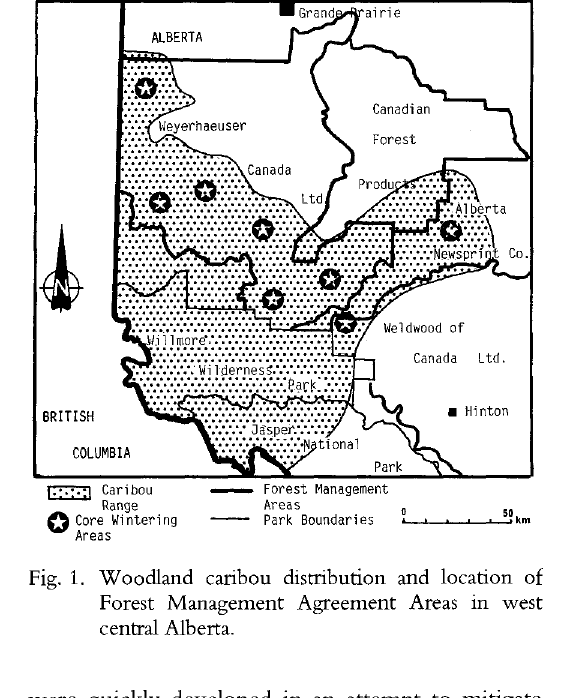
Fig. 1. Woodland caribou distribution and location of Forest Management Agreement Areas in west central